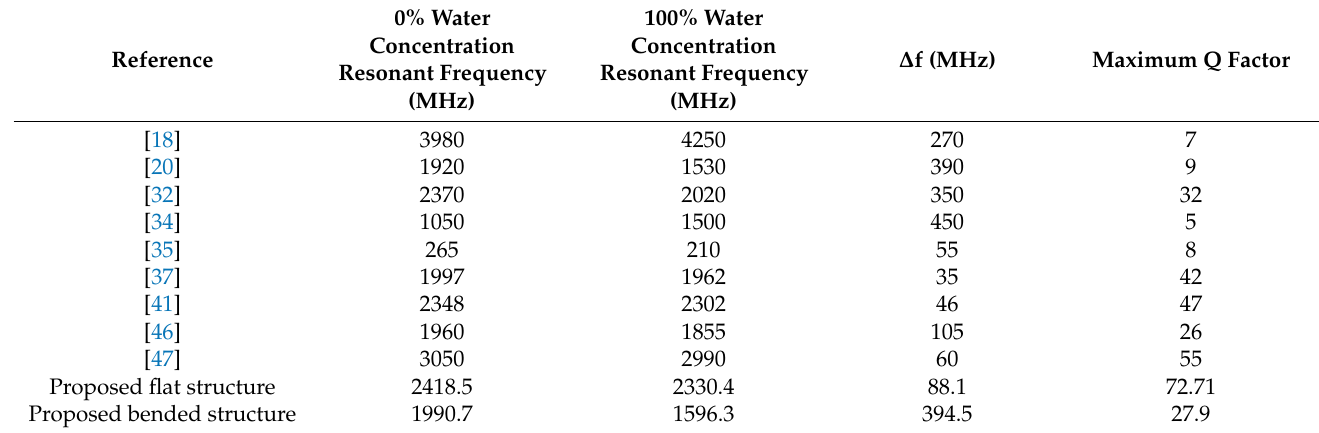
Table 4. Comparison of the proposed sensor with data reported in the